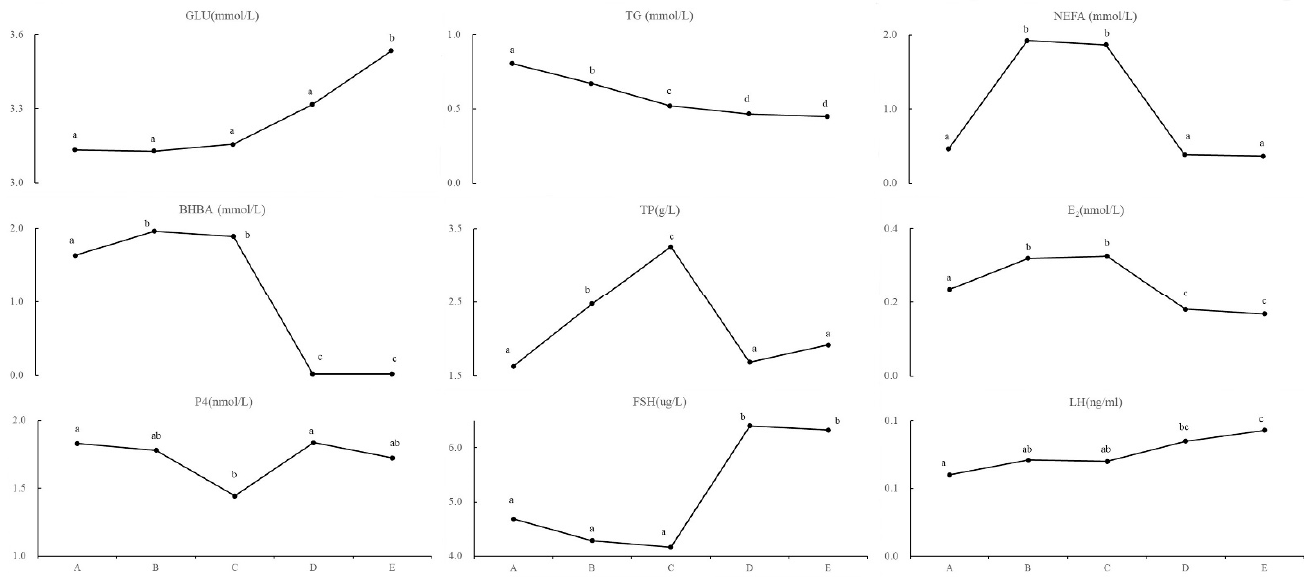
Figure 1. The detective results of serum indexes. GLU: glucose; TG: glucose; NEFA: non esterified fatty acids; BHBA: β hydroxybutyric acid; TP: total protein; E 2 : estradiol; P4: progesterone; FSH: follicle stimulating hormone; LH: luteinizing hormone; A–E: every 7 days from the day of delivery until 28 days after delivery (5 time points). There was significant difference between each two time points marked different letter ( p < 0.05).